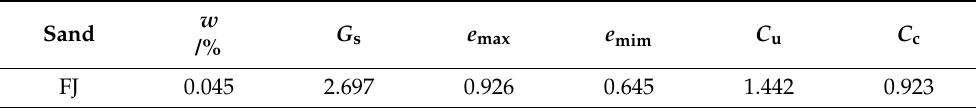
Table 5. Physical index of FJ sand.